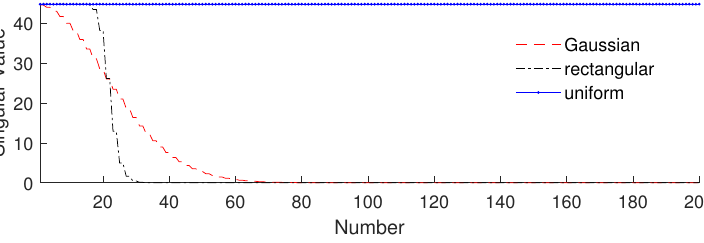
Figure 1. The singular values of different weighted sensing matrices.